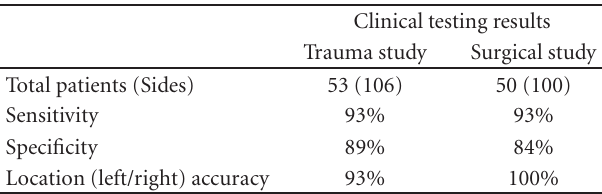
Table 1: Preliminary device performance.